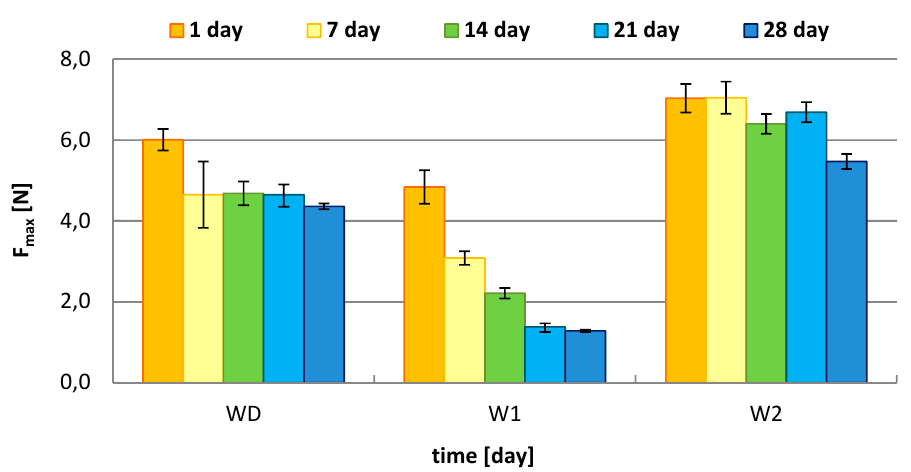
Figure 2. Maximum mechanical strength to compression of capsules containing 6 g goethite/1.5 mL − 1 alginate after keeping them in deionized water (WD) and in natural waters (W1, W2).